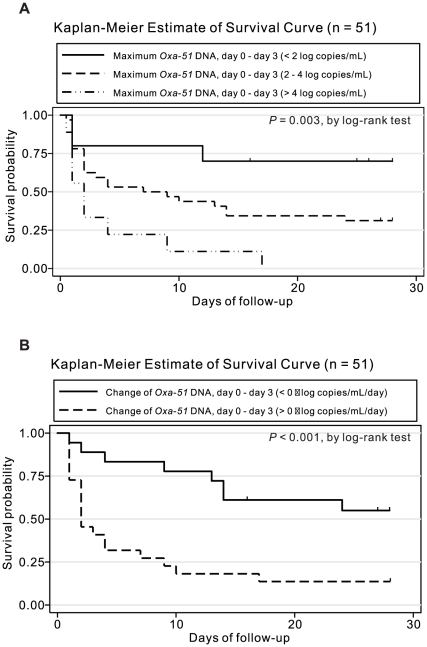
Kaplan-Meier survival curves in patients with A. baumannii bacteremia.Comparison among subgroups with different maximum Oxa-51 DNA load (A) and increased or decreased Oxa-51 DNA (B) from day 0 to day 3.